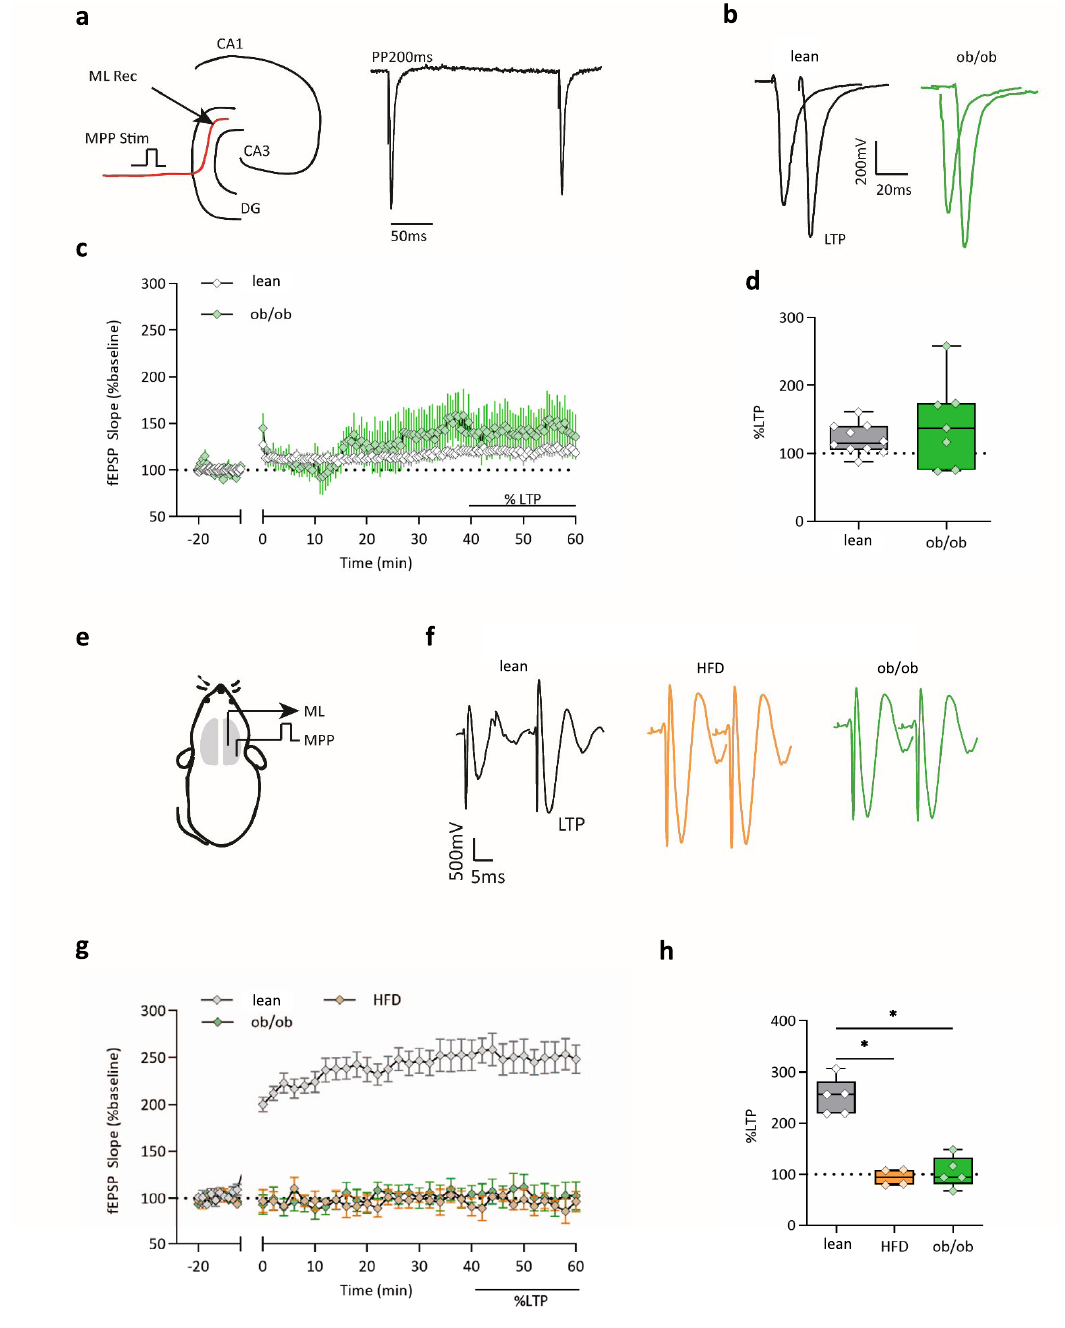
Fig. 4 Obesity impairs LTP at the medial perforant pathway. a Experimental con fi guration of LTP recording in lean and ob/ob mice in brain slices. Position of the stimulating and recording electrodes in the molecular layer (ML Rec) and medial perforant path (MPP stim), respectively. The stimulation of the MPP fi bers induces a paired-pulse depression. b Representative fEPSPs were recorded before and after the induction of the LTP in the two genotypes. c Plot of the fEPSP slope recorded in brain slices before and after the induction of the LTP (time 0) in the DG of lean and ob/ob mice. Data are presented as mean values ± SEM. The extent of LTP was calculated as a percentage of the baseline between the last 40 and 60 min of recording. n = 10 slices from four lean mice and n = 7 slices from four ob/ob mice. d Box plot of the LTP in lean and ob/ob mice, n = 10 slices from four mice in lean (slope 40 − 60 min post HFT = 120.5% ± 6.9%) and seven slices from four ob/ob mice (slope 40 − 60 min post HFT = 143.5% ± 24.37%). e Schematic representation of the in vivo LTP recording, the stimulation electrode was placed in the MPP, the recording site was in the ML. f Representative traces recorded in lean, HFD, and ob/ob before and after the TBS. g Plot of the fEPSP slope recorded before and after the induction of the LTP (time 0) in the DG of n = 5 lean mice, n = 4 HFD mice, and n = 5 ob/ob mice; data are presented as mean values ± SEM, as the extent of LTP was calculated as a percentage of the baseline between the last 40 and 60 min of recording. h Box plot of the LTP in lean, HFD, and ob/ob mice, n = 5 lean mice; n = 4 HFD and n = 5 ob/ob mice. TBS in lean: 251.4%± 16.09%; 94.01%± 8.03%, in HFD, 103.55% ± 13.48% in ob/ob, Kruskal − Wallis test and post hoc Dunn ’ s test, * p < 0.05, Kruskal − Wallis statistic = 9.1. The box plots elements are: center line, median (Q2); square symbol, mean; box limits, 25th (Q1) − 75th (Q3) percentiles; whisker length is determined by the outermost data points. Source data are provided as a Source Data fi